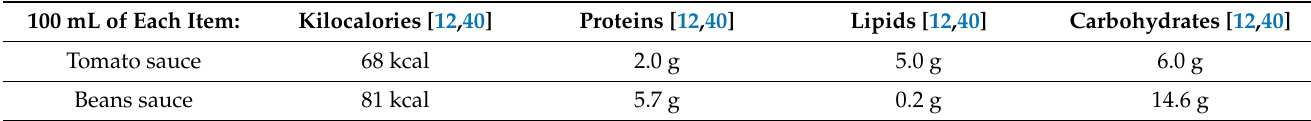
Table 5. Nutritional values of tomato and bean